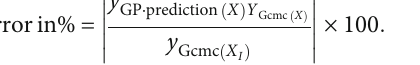
Figure 3: Precision rate of